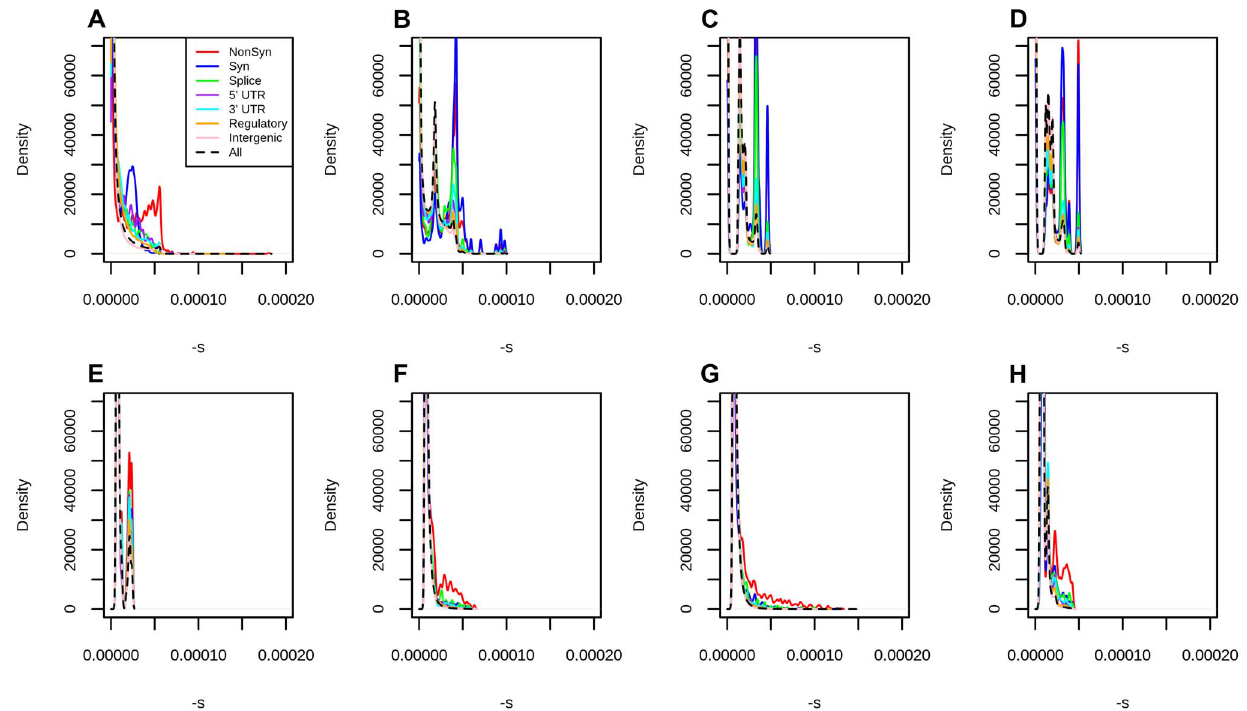
Figure 3. Distribution of fitness effects at different classes of polymorphisms in Yoruba, using different types of conservation scores for mapping. A) C-Scores. B) Primate PhastCons scores. C) Mammal PhastCons scores. D) Vertebrate PhastCons scores. E) Primate PhyloP scores. F) Mammal PhyloP scores. G) Vertebrate PhyloP scores. H) Gerp S scores. We attempted to equalize the range of all scores by converting each score to